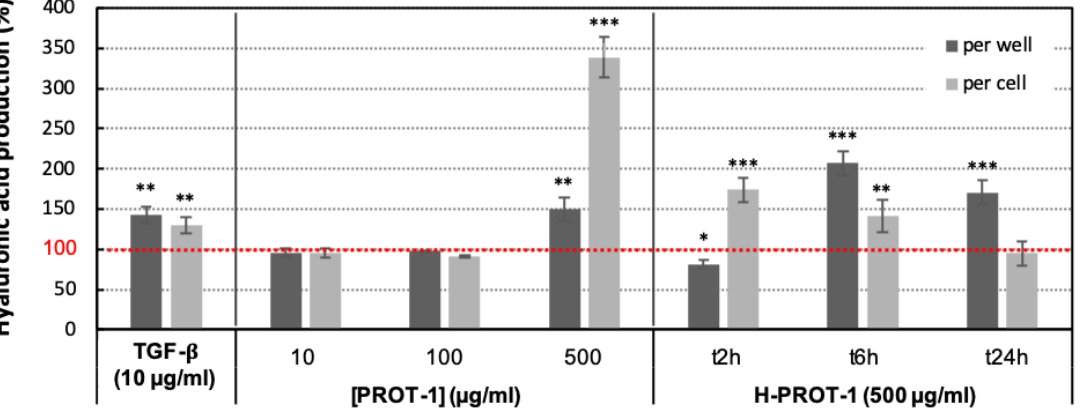
Figure 10. Hyaluronic acid production per well and per cell by the human dermal fibroblast cell line 1090. Results are expressed as the mean relative percentage of production, compared to the negative control (100%). Significant differences between values obtained with samples and negative control ( n = 9) by * ( p < 0.05), ** ( p < 0.01) and *** ( p < 0.001).